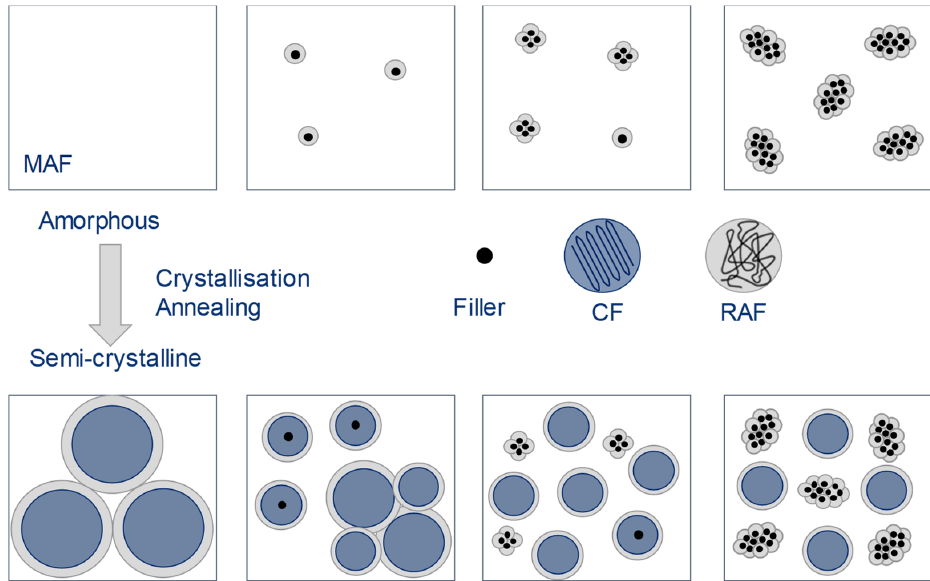
Figure 2. Rigid amorphous phase around crystalline domains and filler particles [12]. Depending on the amount added, the particles can come together to form agglomerates. An RAF can develop both as part of crystals and around additives.